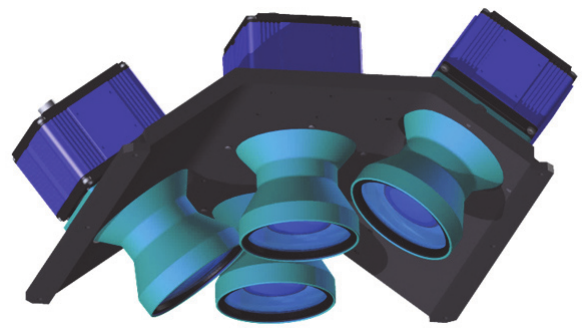
Figure 3. Sensor head with the Himalaya expedition configuration (illustration). The footprint of the bridge is 255x255